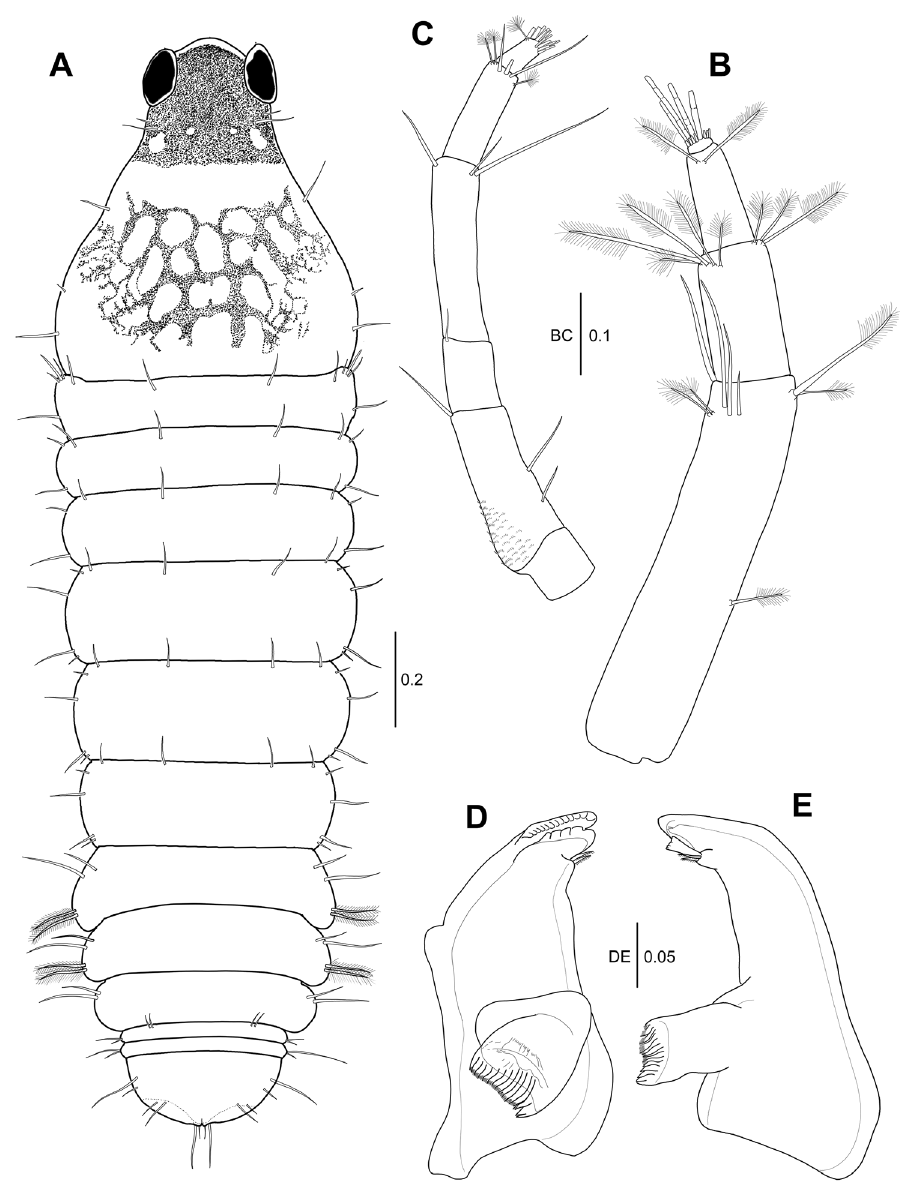
Figure 11. Hexapleomera ulsana sp. n., Jeju population, male, A habitus, dorsal B antennule C antenna D left mandible E right mandible. Scale bars in